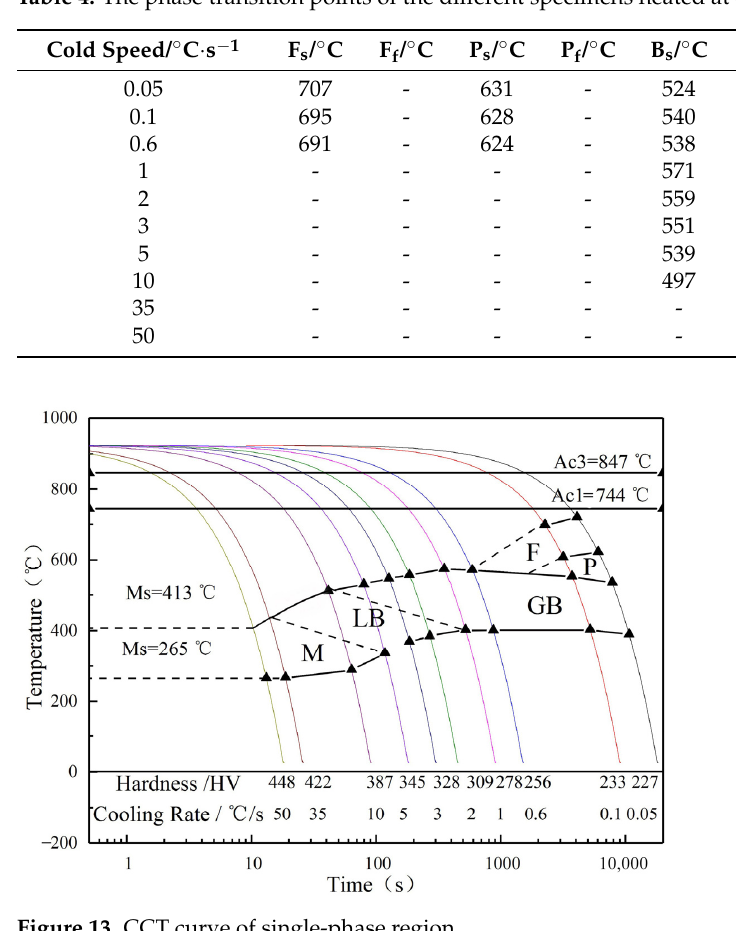
Figure 13. CCT curve of single-phase region. Table 4. The phase transition points of the different specimens heated at 830 °C.